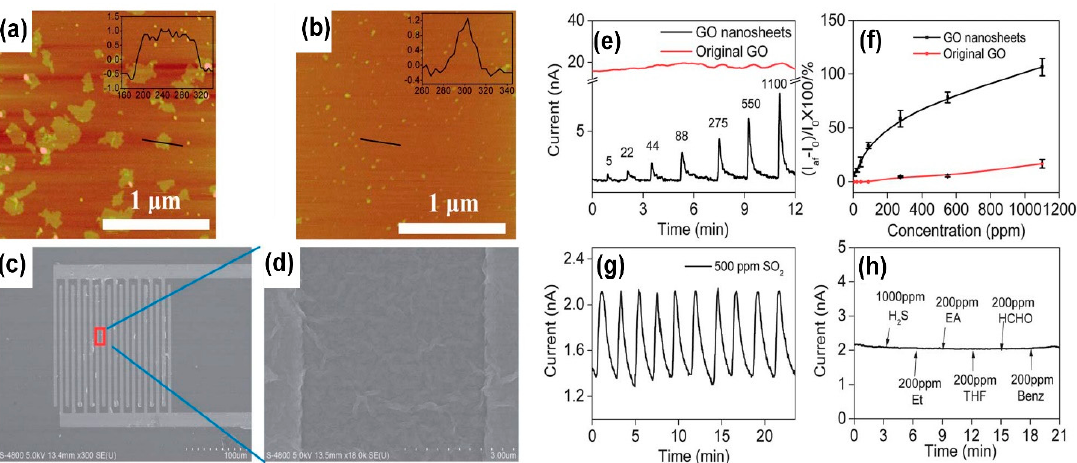
Figure 9. Panel ( a ): AFM image of the pristine GO flakes. The height profile of a flake is reported in the inset; Panel ( b ): AFM image of the tailored GO flakes. The height profile of a flake is reported in the inset; Panel ( c ): SEM image of the interdigitated electrodes on the FET device; Panel ( d ): SEM image of the GO flakes bridging the electrodes; Panel ( e ): response to different concentrations of SO 2 of pristine GO (red curve) and tailored GO flakes (black curve); Panel ( f ): current vs. SO 2 concentration graph of the pristine GO (red curve) and tailored GO flakes (black curve); Panel ( g ): ten cycles of the tailored GO flakes for response to 500 ppm of SO 2 ; Panel ( h ): real time response of the tailored GO flakes to other gases. (Adapted and reproduced with permission of RSC Pub., Cambridge, United Kingdom, from [87]; permission conveyed through Copyright Clearence Center, Inc.).